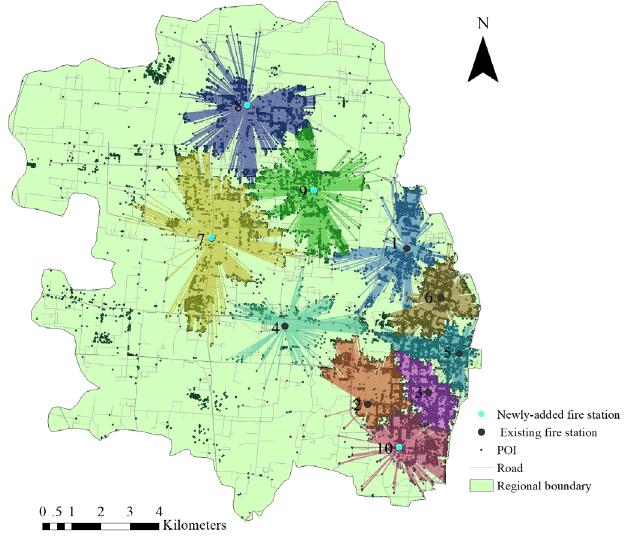
Figure 6. Location of optimized fire stations. (The lines with different colors represent the POIs assigned to different fire stations.) Table 4. The number of POIs covered by each fire station after short-term planning.